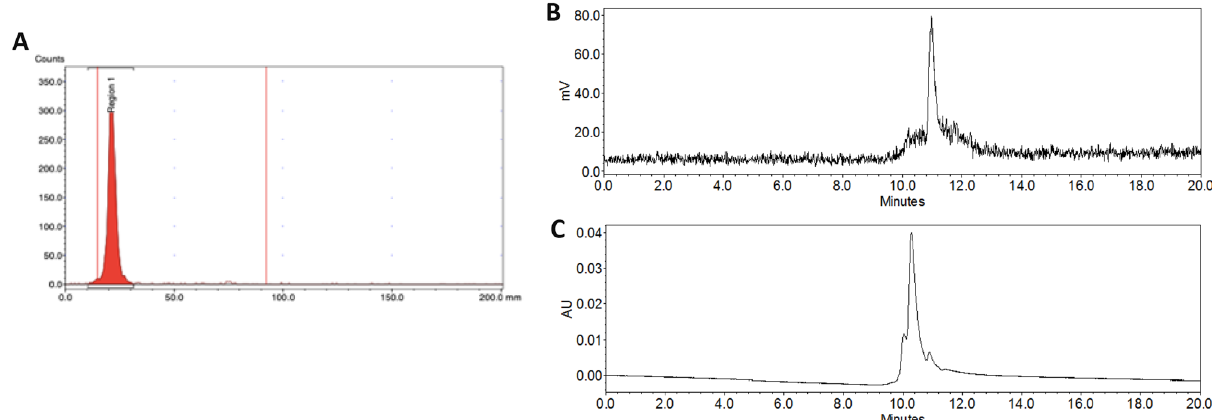
Figure 7. Purified [ 18 F]SFB-nanobody ( A ) Radio-TLC, ( B ) size-exclusion chromatography (γ detector) and ( C ) reference nanobody (UV detector, 280